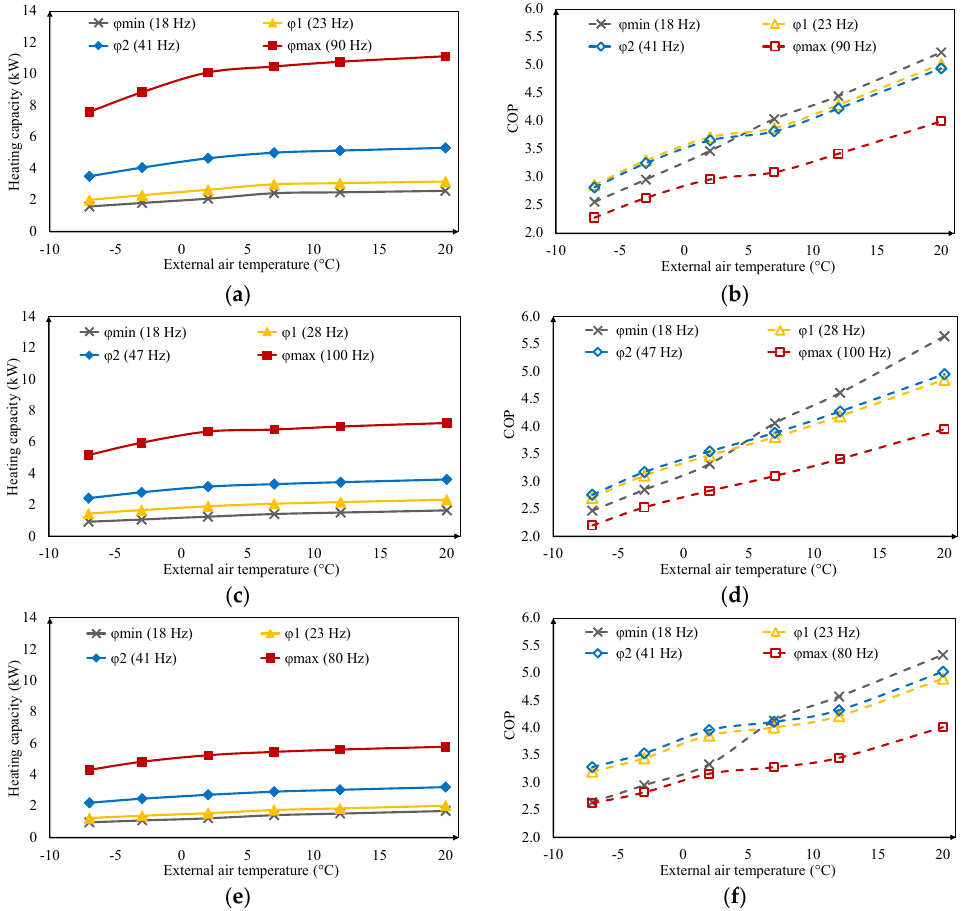
Figure 3. Performance data of the modeled variable-speed air-to-water heat pumps: ( a ) Heating capacity and ( b ) COP of Unit 1; ( c ) Heating capacity and ( d ) COP of Unit 2; ( e ) Heating capacity and ( f ) COP of Unit 3.